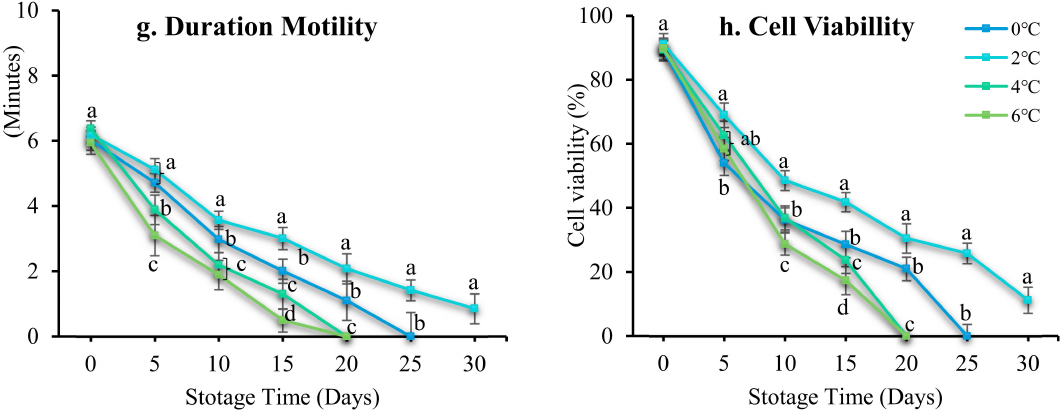
Figure 3. Effect of storage temperature on the function of spotted halibut ( Verasper variegatus ) for 15 days at 4 ◦ C. ( a ) Motility (%), ( b ) average path velocity (VAP; µ m/s), ( c ), curvilinear line velocity (VCL; µ m/s) ( d ) straight-line velocity (VSL; µ m/s), ( e ) linearity (LIN; %), ( f ) straightness (STR; %), ( g ) duration motility (minutes), and ( h ) cell viability (%). Various lowercase letters represent substantial changes across storage temperatures ( p <